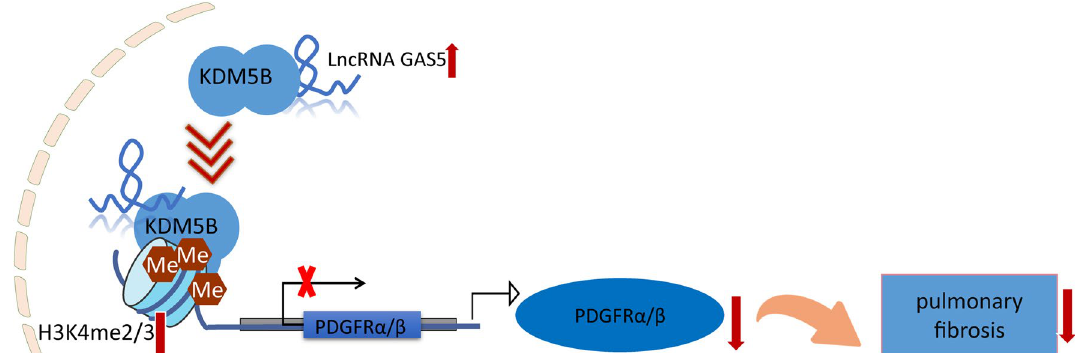
Fig. 9 A schematic map illustrating the role and mechanism of lncRNA GAS5 in pulmonary fibrosis. GAS5 recruited KDM5B to facilitate H3K4me2/3 demethylation that reduced PDGFR α/β transcription and expression, thus inhibiting pulmonary